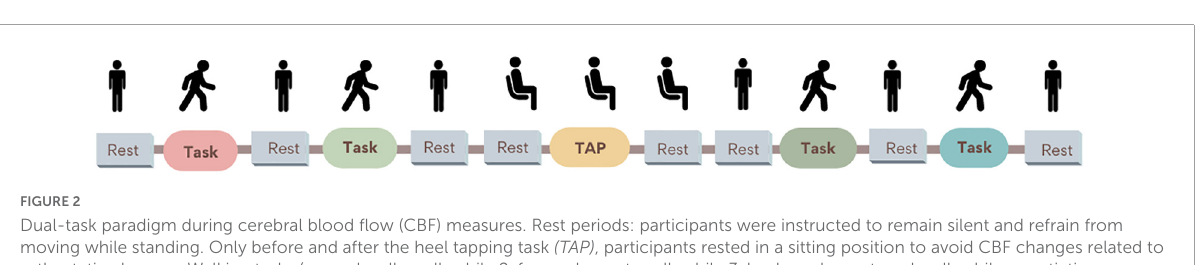
FIGURE2 Dual-task paradigm during cerebral blood flow (CBF) measures. Rest periods: participants were instructed to remain silent and refrain from moving while standing. Only before and after the heel tapping task (TAP) , participants rested in a sitting position to avoid CBF changes related to orthostatic changes. Walking tasks (normal walk, walk while 2-forward count, walk while 3-backward count, and walk while negotiating obstacles) order was randomized to minimize the fatigue